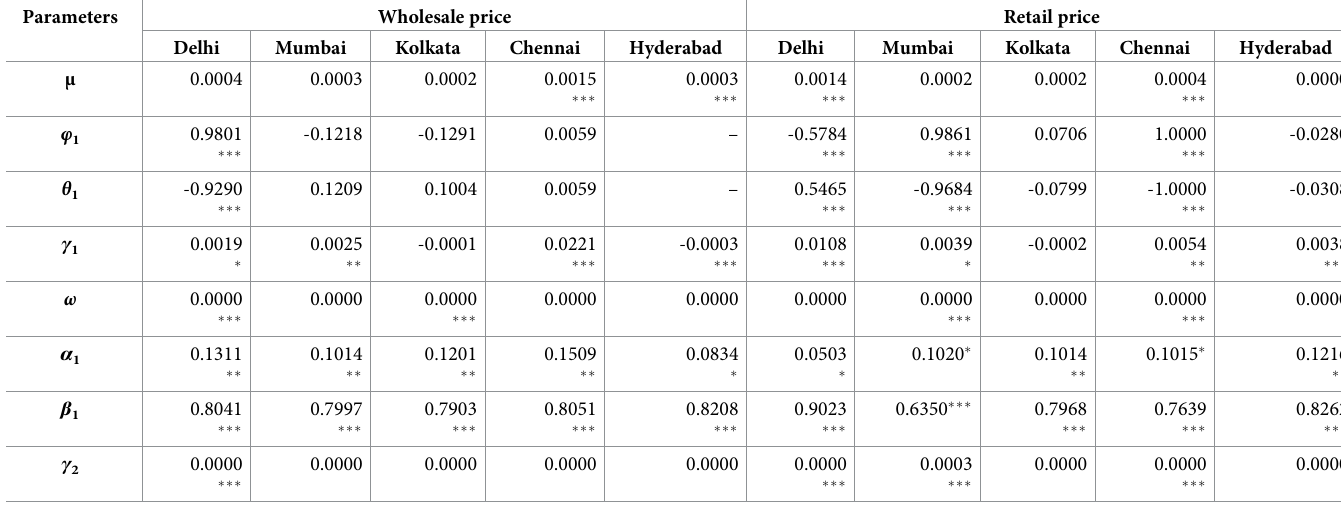
Table 4. Parameters estimate of GARCH-X model for moong.